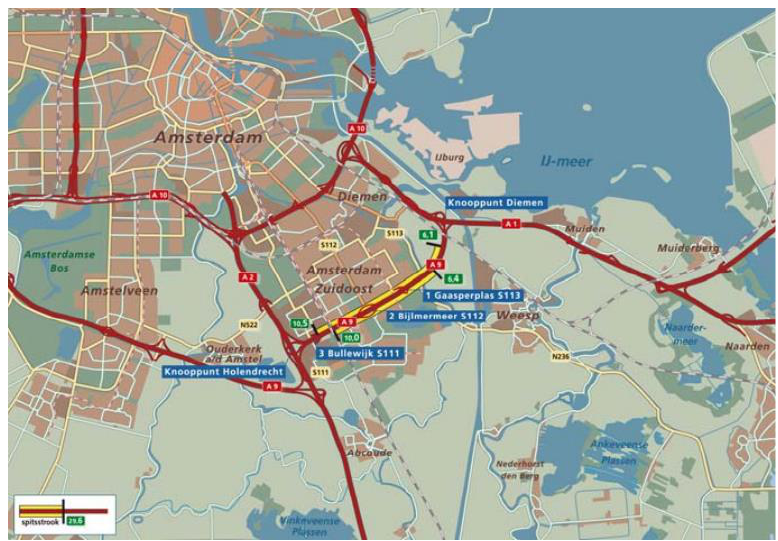
Figure 1. South East Amsterdam (the Diemen – Holendrecht stretch is colored yellow)